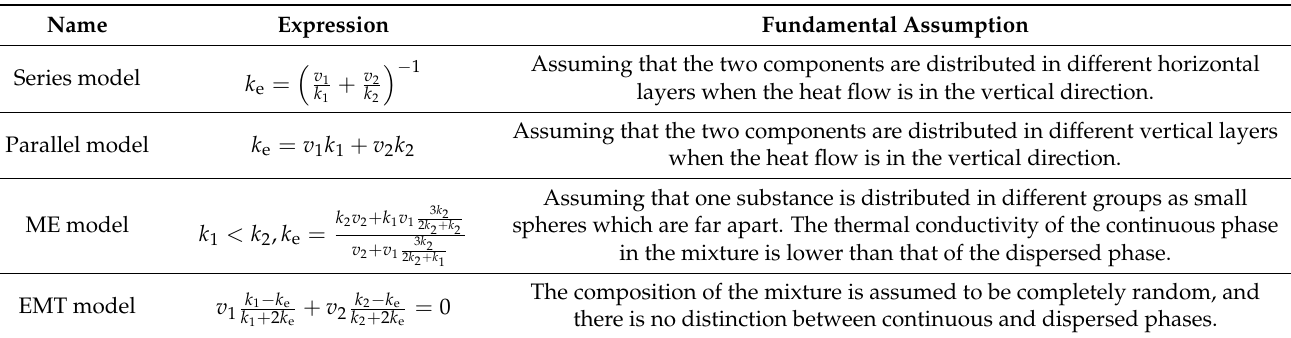
Table 3. Description of the effective thermal conductivity